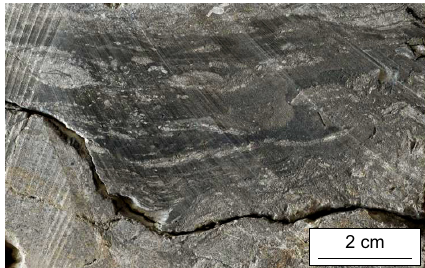
Figure 18. Photograph of dark, macroscopically gouge-similar, bedding-parallel bands from drill core BDB-1. This is to indicate that, contrary to the hypothesis of authigenic gouge generation, gouge could be allogenic, being smeared-in from such dark bands. Next to the Main Fault, however, those bands are not reported. See text for